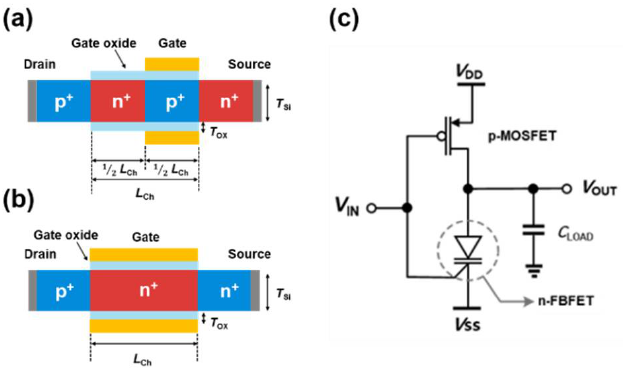
Figure 1. Cross section of a ( a ) SiNW n-FBFET and ( b ) a SiNW p-MOSFET. ( c ) Logic-in-memory (LIM) inverter comprising n-FBFET and p-MOSFET with load capacitor ( C LOAD ). Supply voltages V DD and V SS connected to the p-MOSFET and n-FBFET sources, respectively.